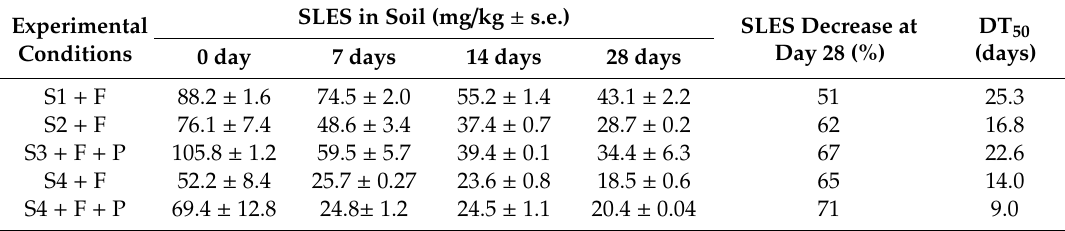
Table 5. SLES concentrations (mg / kg) in soils collected from the various conditioned microcosms over 28 days; SLES decreased (%) at day 28 and calculated disappearance times of 50% of the initial SLES concentration (DT 50 ). (s.e. = standard error).